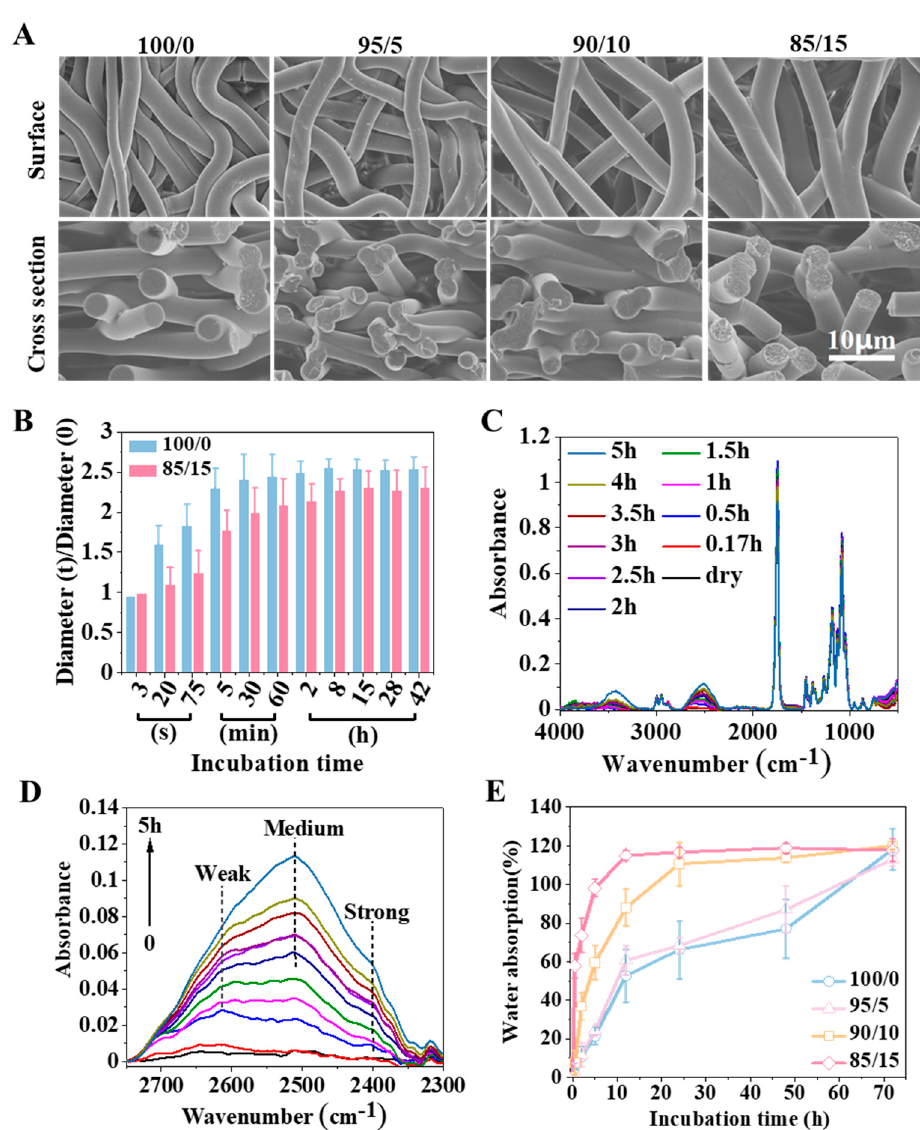
Figure 5. Swelling behavior of fibrous membrane. ( A ) SEM images of the electrospun membranes (i.e., 100/0, 95/5, 90/10, and 85/15). ( B ) Diameter changes of the 100/0 and 85/15 electrospun fibers. Here, 0 and t represent the initial state and the state at time t, respectively. ( C , D ) ATR-FTIR spectra for the process of deuterated water diffusion in the 85/15 membranes. ( E ) Water absorption of the electrospun membranes (i.e., 100/0, 95/5, 90/10, and 85/15) during swelling.